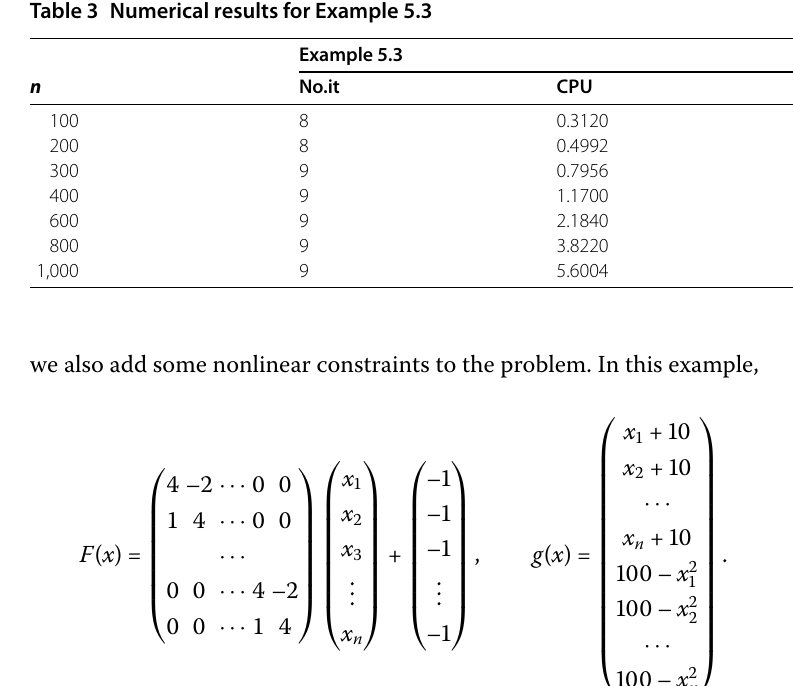
Table 3 Numerical results for Example 5.3